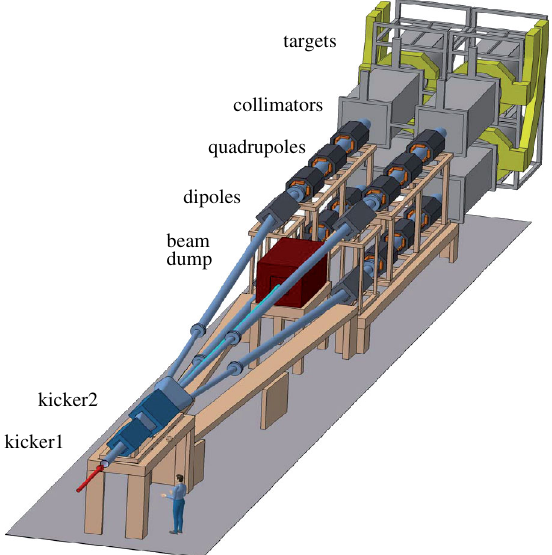
FIG. 3. The beam transport and distribution system.